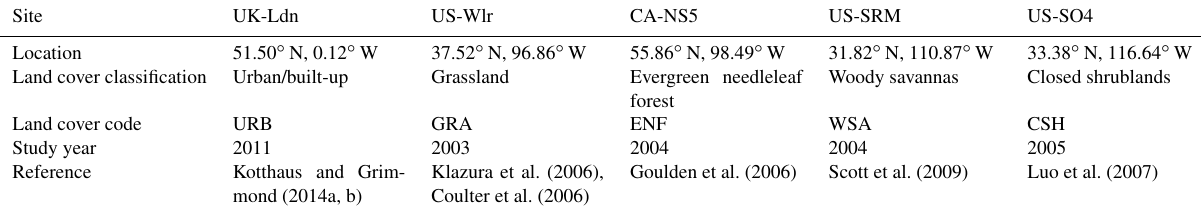
* midday period: 1000–1400 local standard time. Table 2. Characteristics of the flux towers at the study